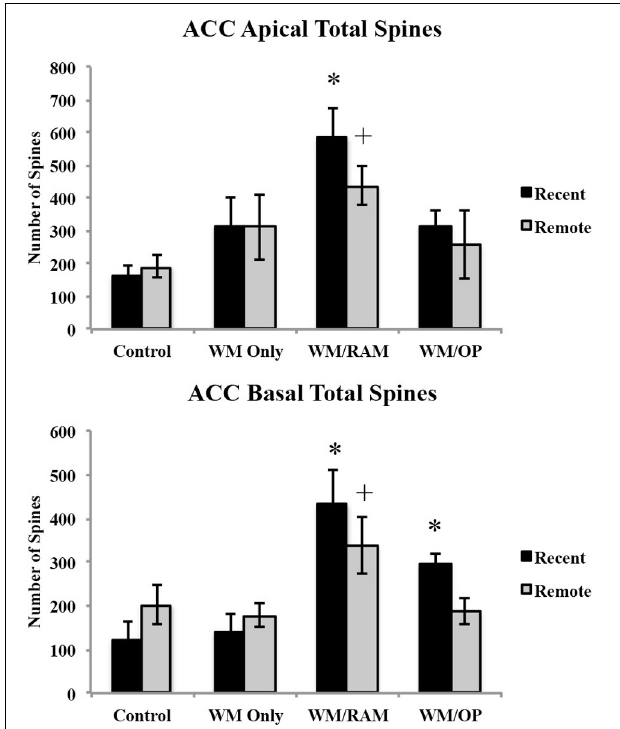
FIGURE 7 | Spine density in the ACC in apical and basal dendrites. Only significant differences between behavioral groups and their respective control group are displayed. Refer to Results section for all comparison results. ∗ Significantly different from Control:recent group ( p < 0 .